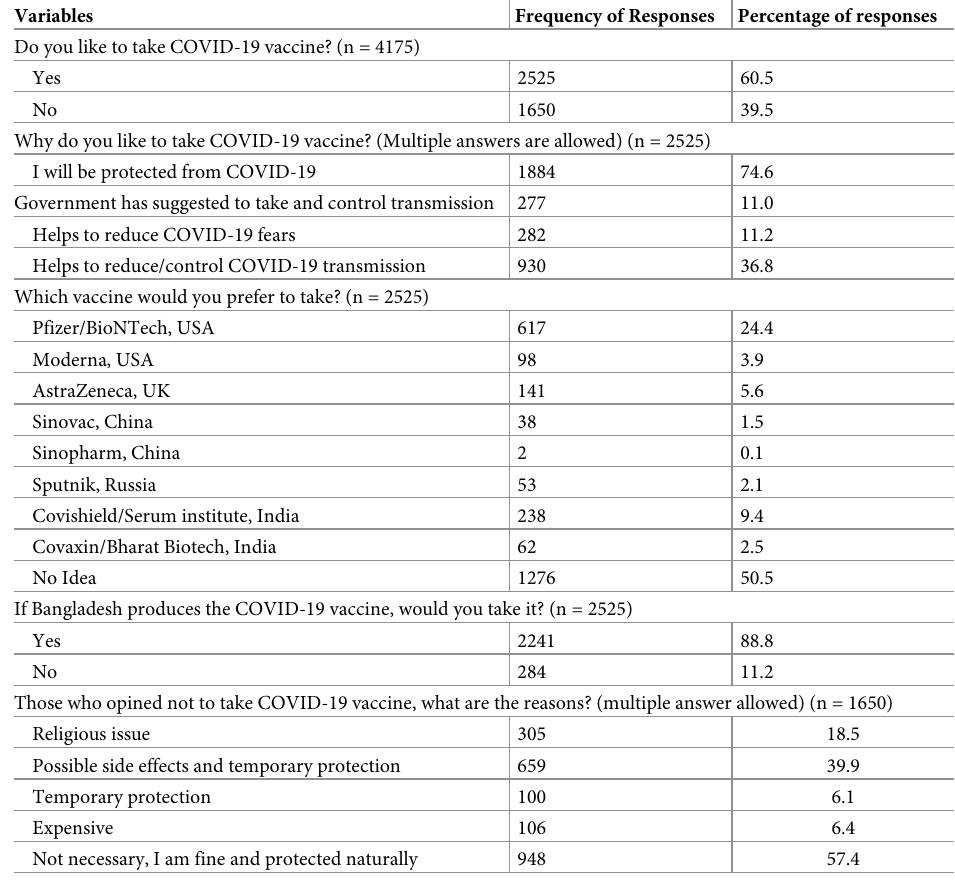
Table 3. Respondents’ opinion on acceptance of COVID-19 vaccine.